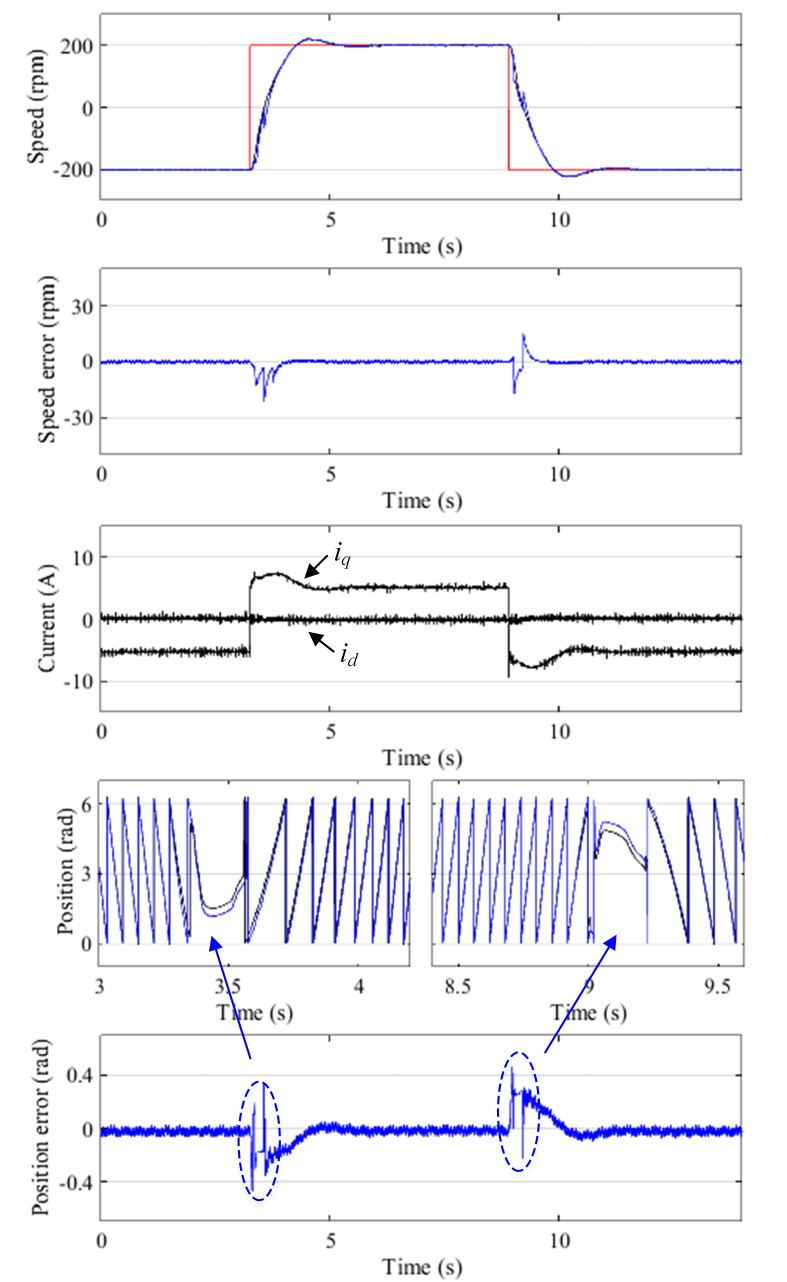
Figure 8. The speed changes between 200 rpm (0.1 p.u.) and − 200 rpm ( − 0.1 p.u.). “Red Line” represents the reference signals, “Black” means measured signals and “Blue Line” denotes the signals that are obtained by using the proposed